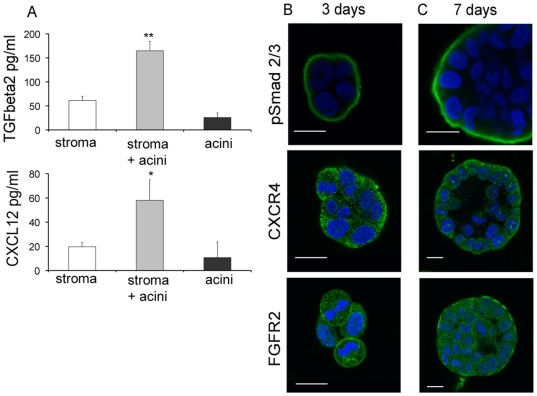
Paracrine signalling of TGFβ2, CXCL12 and FGF10.(A). Protein levels of TGFβ2 or CXCL12 were determined using ELISA. Medium was collected after 3 days growth from stroma or 3D BPH-1 acini cultured alone or in co-culture (n = 6). The datum is typical of results from three separate stroma, ** = p<0.05 (paired t-test). (B and C). 3D BPH-1 acini were fixed at day 3 and day 7 and immunostained for pSmad 2/3, CXCR4 and FGFR2 (green), imaged at mid sections, DAPI (blue), bars  = 20 µm.